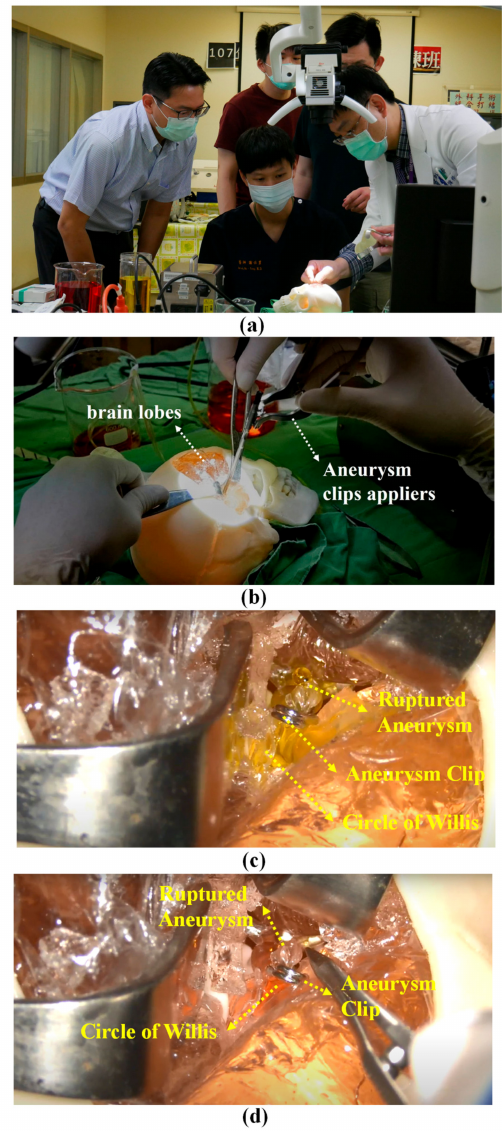
Figure 9. ( a ) An experienced neurosurgeon (Dr. Liu from our research team) gave a